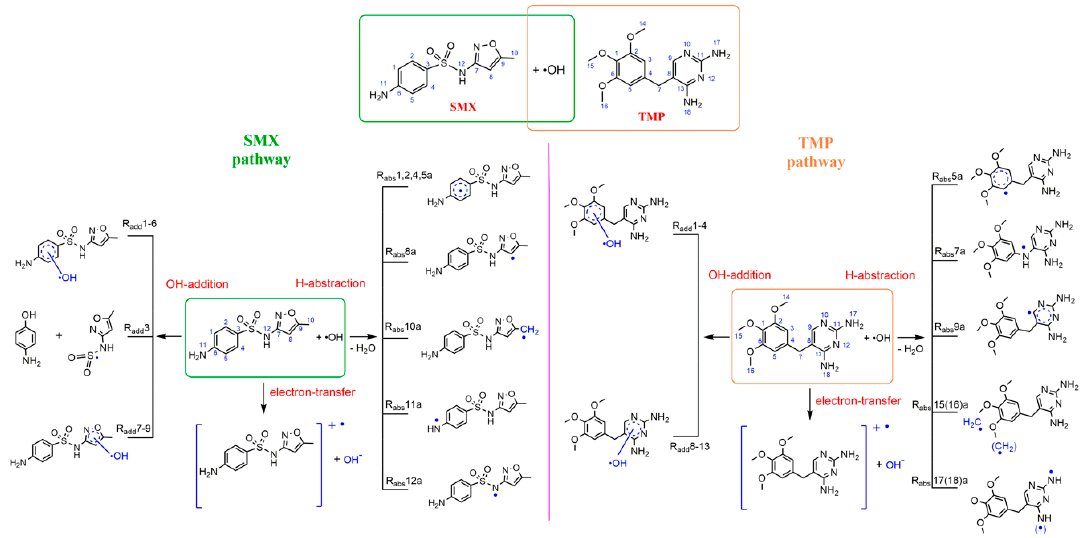
Figure 1. All the reaction pathways in the initial reaction of sulfamethoxazole (SMX) and trimethoprim (TMP) with •OH.